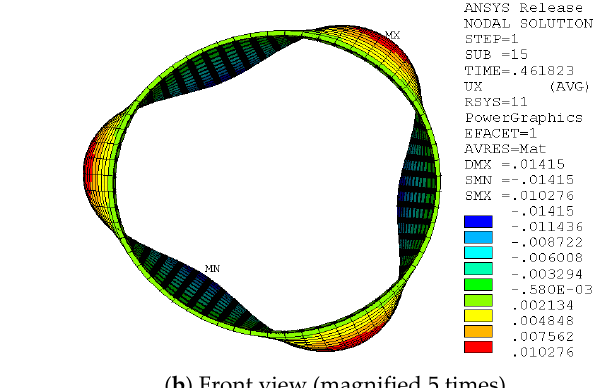
Figure 13. Radial displacement contour map at the upper critical point of the post-buckling path for the model of the T-type stiffened cylinders with the SS3 boundary when the material is brass and ξ = 0.05.